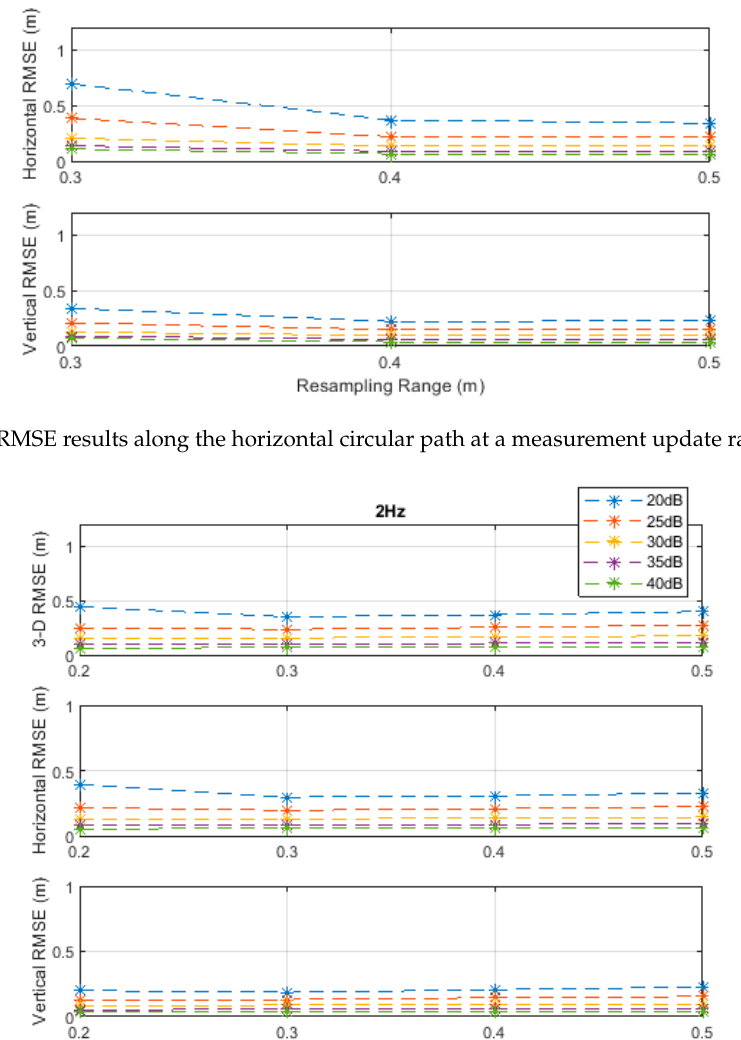
Figure 10. RMSE results along the horizontal circular path at a measurement update rate of 2 Hz.